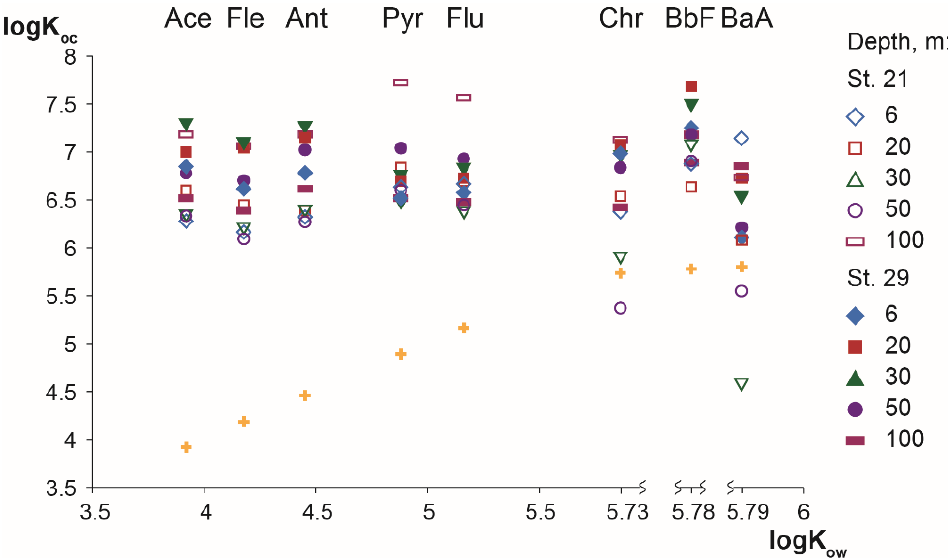
Figure 5. log K oc versus log K ow of individual PAHs in the epipelagic of the Japan Basin (the Sea of Japan). The K ow values were taken from [71]. The yellow crosses mean value of log K ow vs. logK oc for the same PAH.